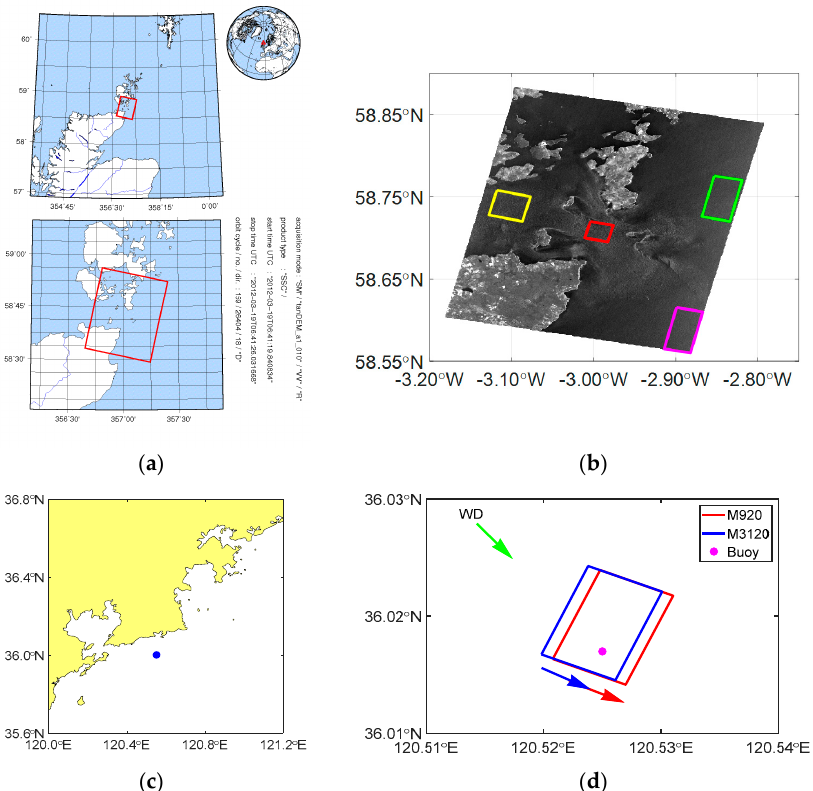
Figure 2. ( a ) The geolocations of the TerraSAR-X and TanDEM-X images used in this paper nearby Pentland Firth, north of mainland Scotland; ( b ) the four subareas in the images for ocean wave inversion used in this paper, and the red, yellow, green, and purple boxes represent A 1 , A 2 , A 3 , and A 4 , respectively; ( c ) the blue dot is the location of the airborne IRA experiment; ( d ) the SAR image locations of the airborne IRA experiment, and the green arrow denotes the wind direction.